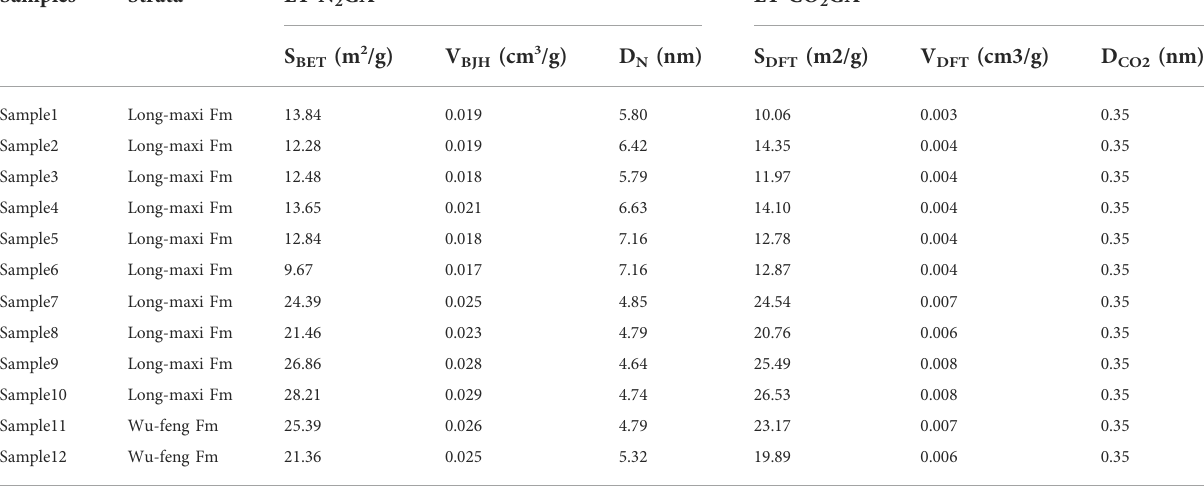
TABLE 2 Pore structural parameters of all